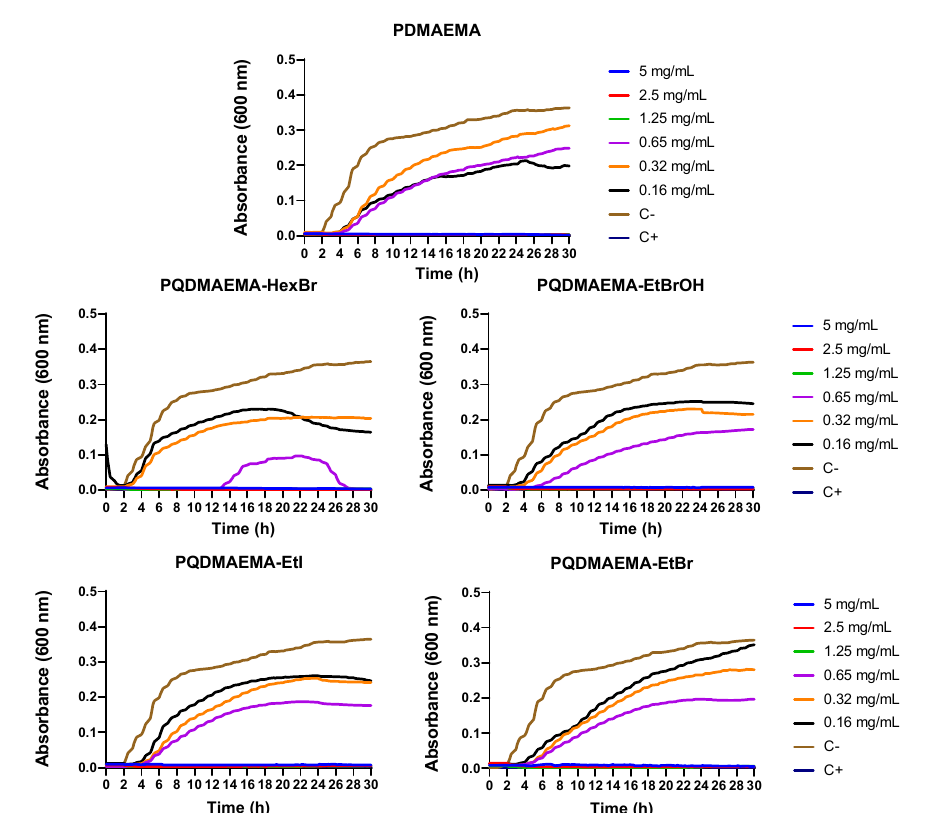
Figure 3. Growth kinetics of E. coli in the presence of polymer concentrations ranging from 0.16 to 5 mg/mL. The optical densities were measured for 30 h incubation at 37 ◦ C using a multi-detection microplate reader at 600 nm and were automatically recorded for each well every 15 min. In all experiments, the bacterial suspension in pure LB and in the presence of amoxicillin/clavulanic acid were measured as the negative (C − ) and positive (C+) control, respectively.